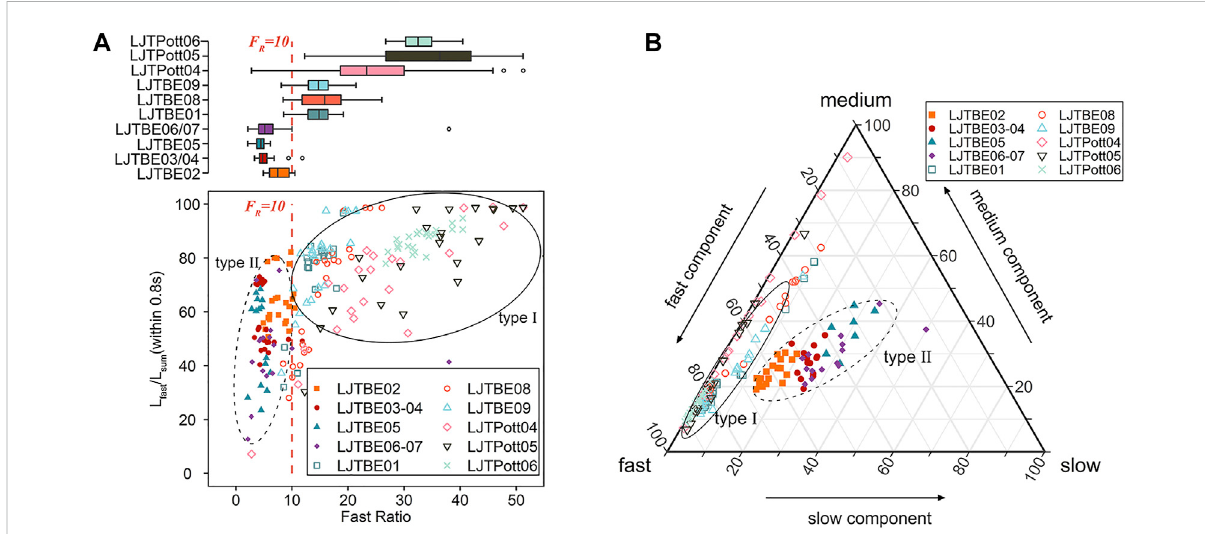
FIGURE 3 (A) The graph shows the Fast Ratio (F R ) versus the proportion of the fast component in the initial signal. The proportion is obtained by calculating the integralofthe fi rst0.8 softheCW-OSLcurve.Thesamplescanbeclassi fi edintotwotypesbasedonF R andL fast /L sum .TheF R valuesoftypeIaregreaterthan 10,andthefastcomponentdominatestheinitialsignal.TheF R valuesofTypeIIsamplesarelessthan10,andthefastcomponentisnotsigni fi cantintheinitial OSL signal. All the data were calculated from the natural OSL decay curves during pure quartz OSL-SAR dating procedures. (B) The ternary diagram showstherelativeproportionsoffast,mediumandslowcomponentsforthepurequartznaturalCW-OSLsignals.Similartotheresultsin (A) ,thesesamples can be classi fi ed into type I and type II according to the relative contributions of the three